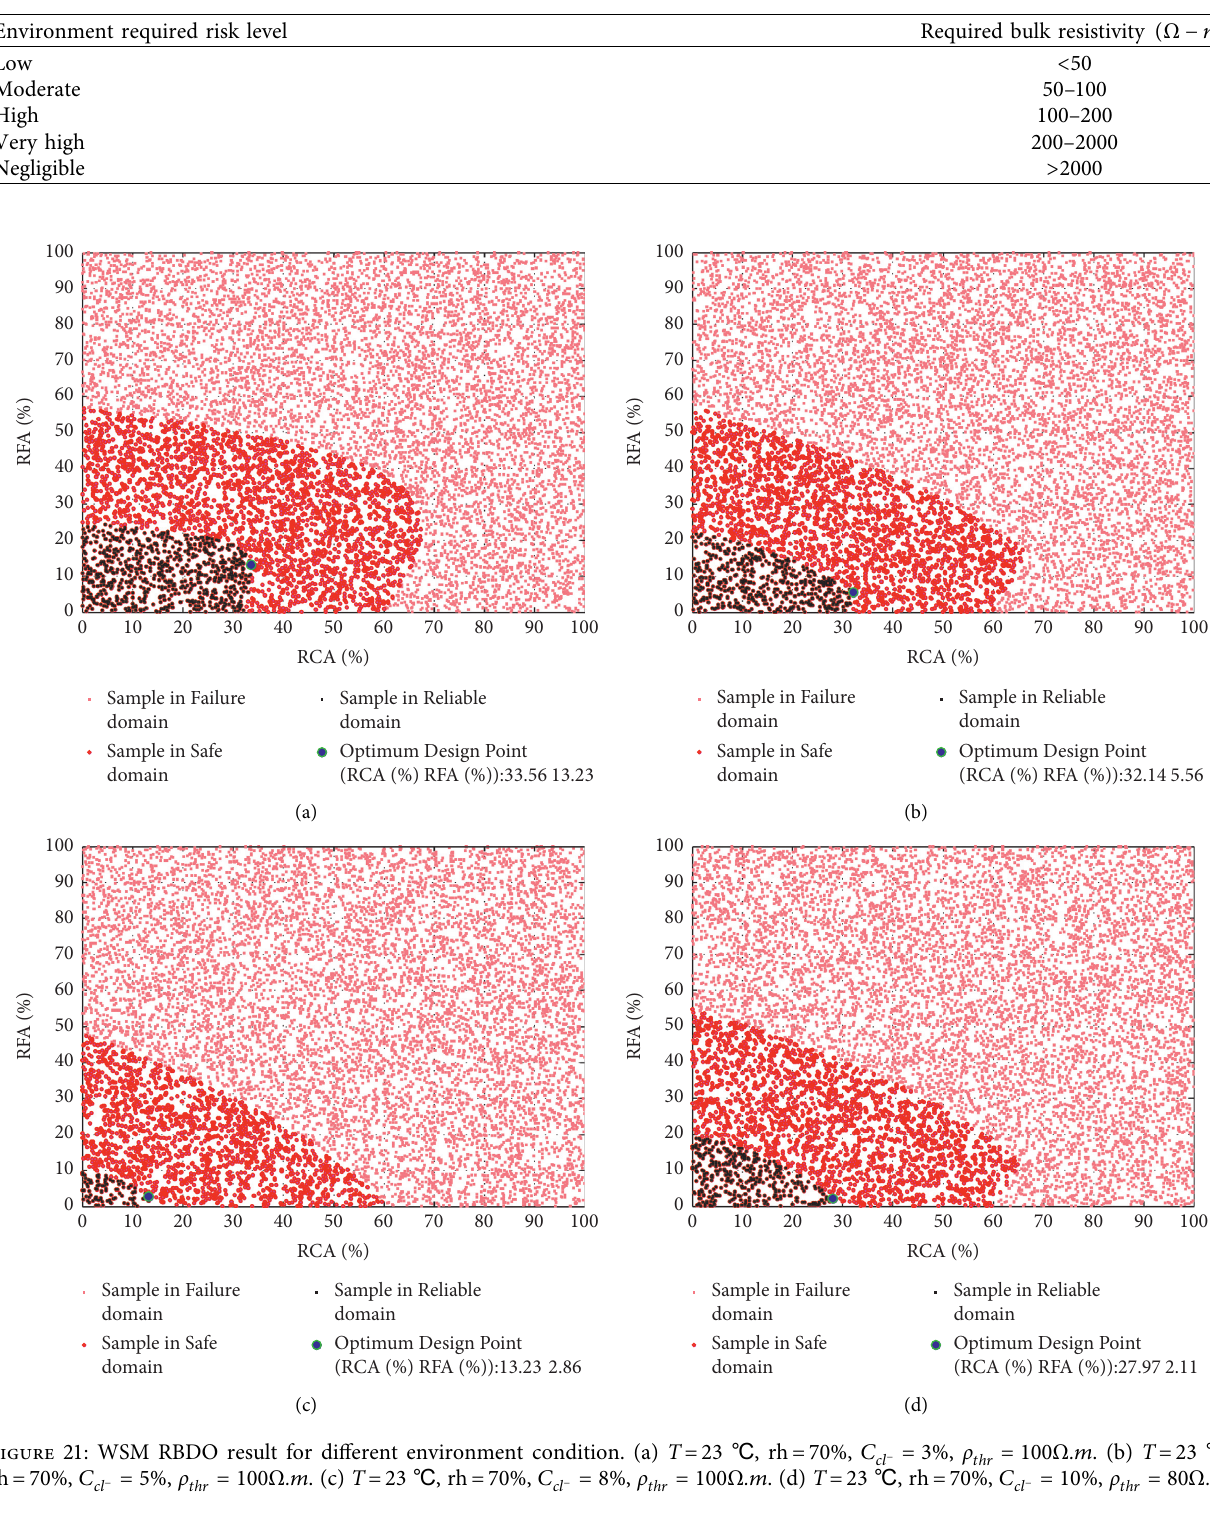
� 3%, ρ � 100 Ω .m . (b) T � 23 ℃ , cl − thr